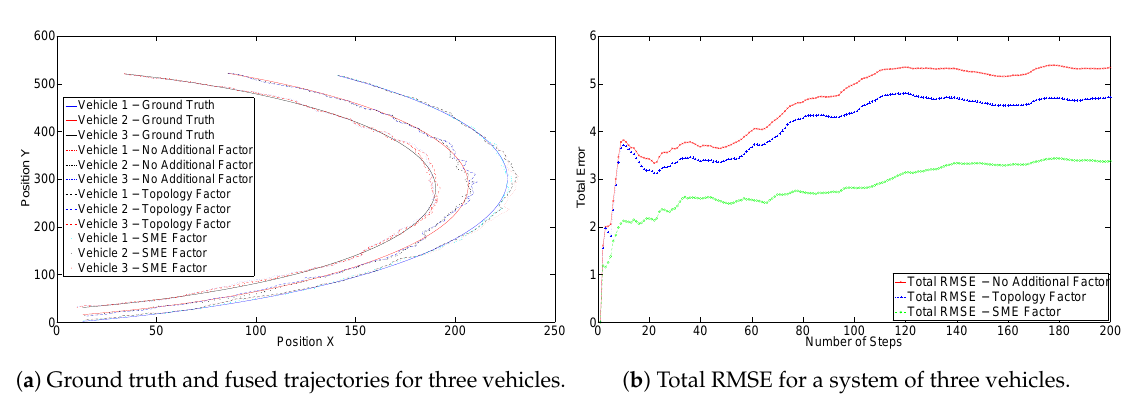
( b ) Total RMSE for a system of three vehicles. Figure 6. Second set without GPS for three trajectories with constant turn model.